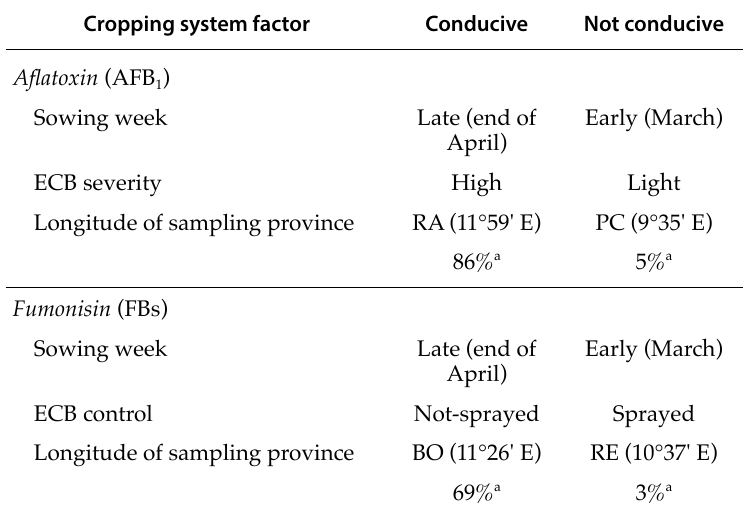
Table 4. Cropping system factors selected by the logistic equations to define conducive/not-conducive scenarios for AFB and FBs contamination in maize